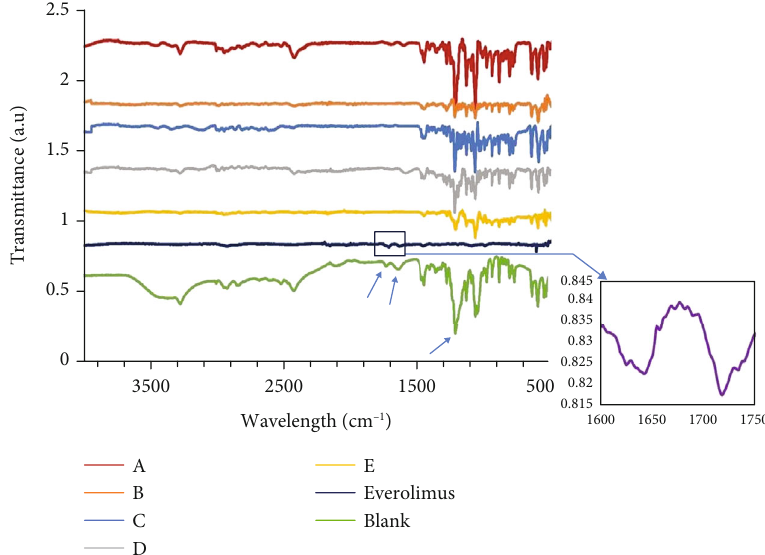
Figure 3: Functional group analysis. ATR-FTIR spectra of samples A-E, free everolimus, and blank